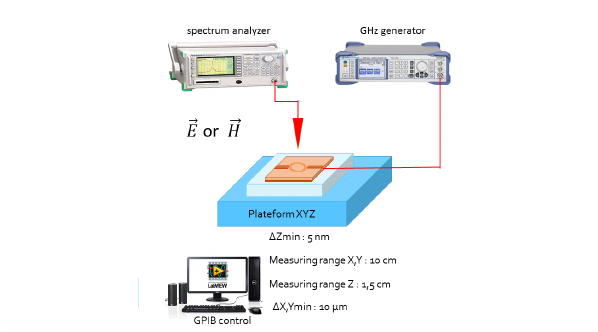
Figure 1: Experimental set-up including spectrum analyzer, GHz generator and XYZ-platform.